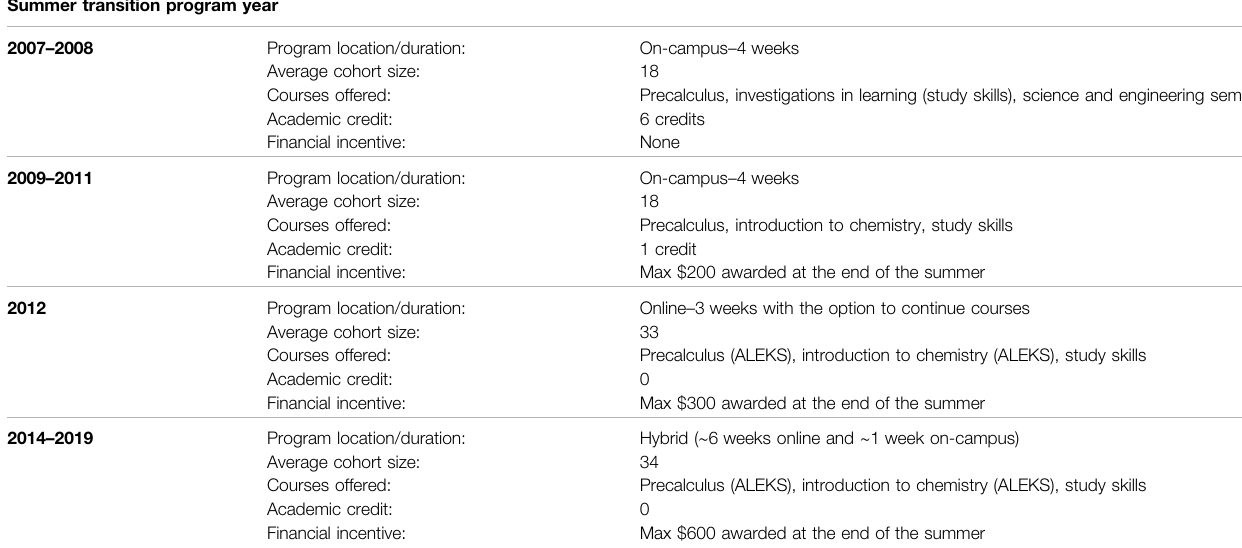
TABLE 2 | VCU LSAMP Summer Transition Program